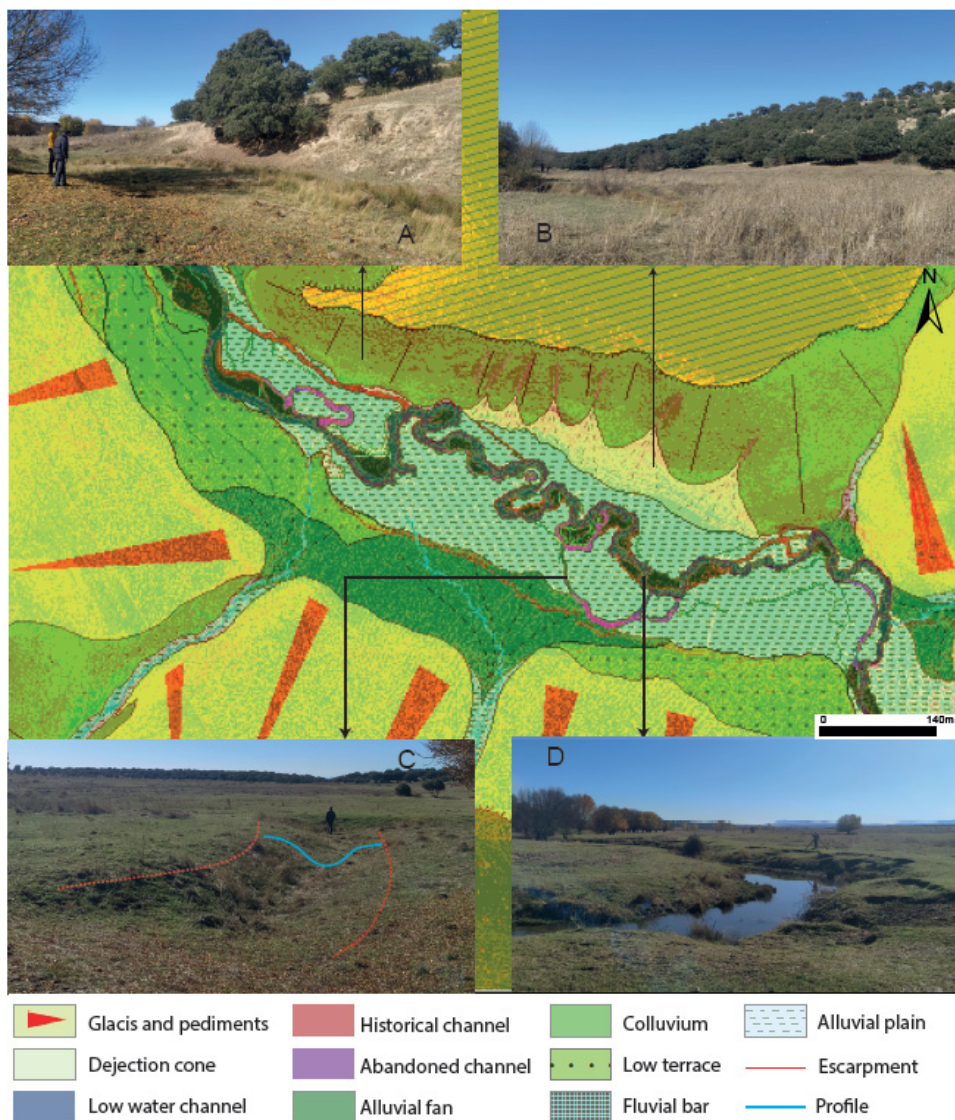
Figure 3. Diagram of the geomorphic elements identified on the slope model: ( A ) Colluvium; ( B ) Alluvial cones; ( C ) Abandoned channel; ( D ) Current low-water channel.